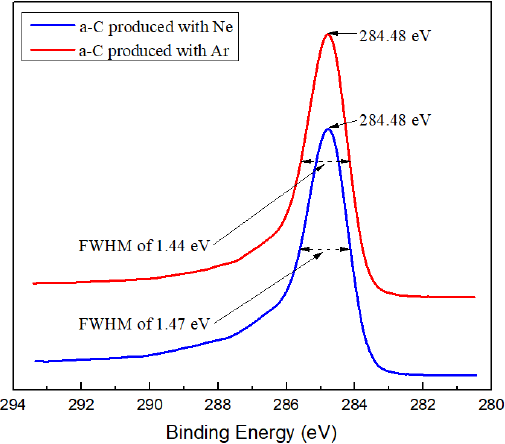
Figure 4. C1s lines of amorphous carbon coatings obtained with Ne and Ar.